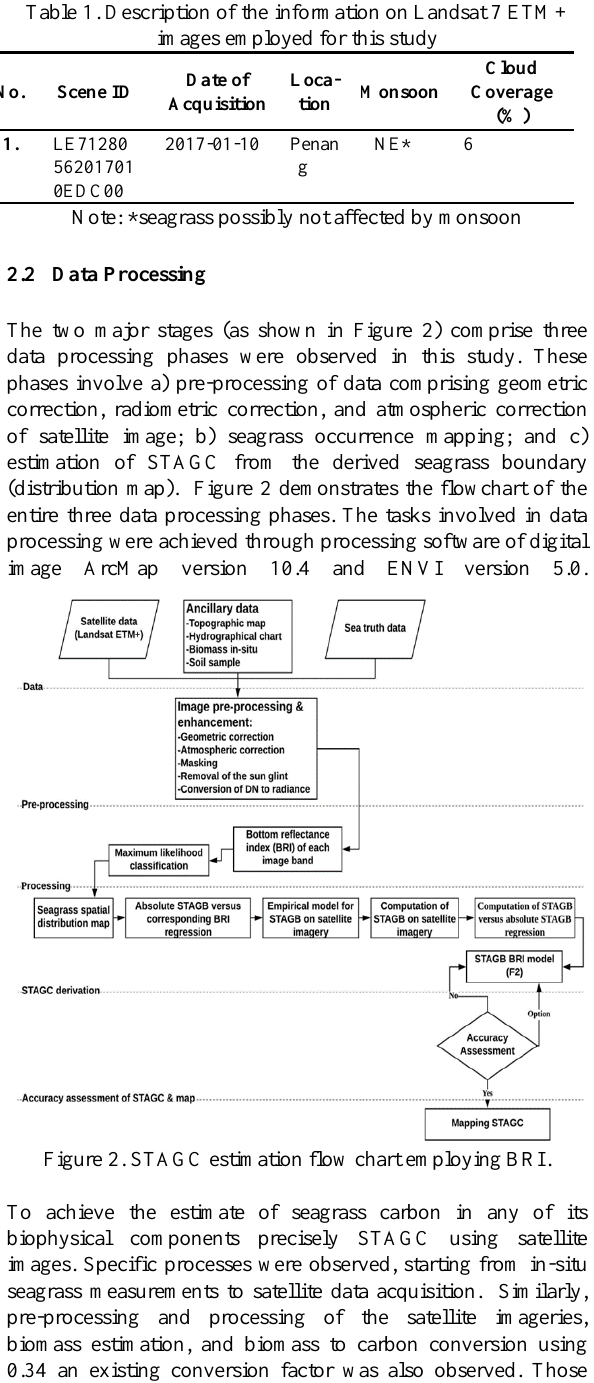
Table 1. Description of the information on Landsat 7 ETM+